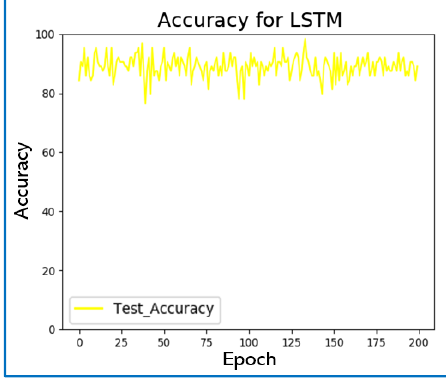
Figure 8. Train accuracy by LSTM algorithm.